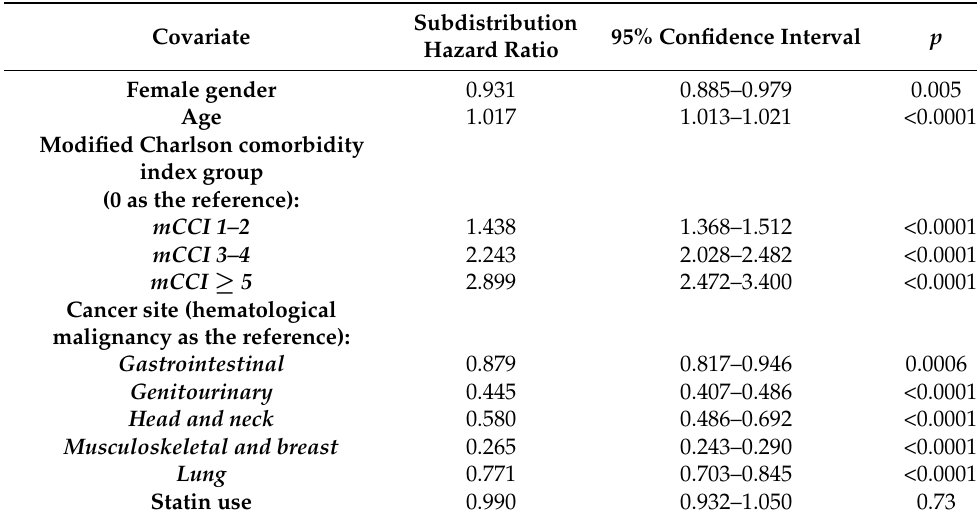
Table 3. Summary of the Fine and Gray model assessing the effect of covariates on the hazard of sepsis, treating death without sepsis as a competing event.